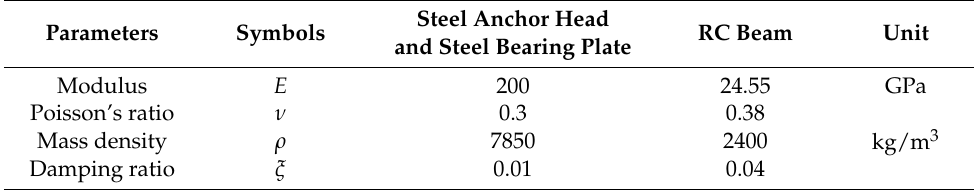
Table 1. The mechanical properties of the structural elements in the FE model.